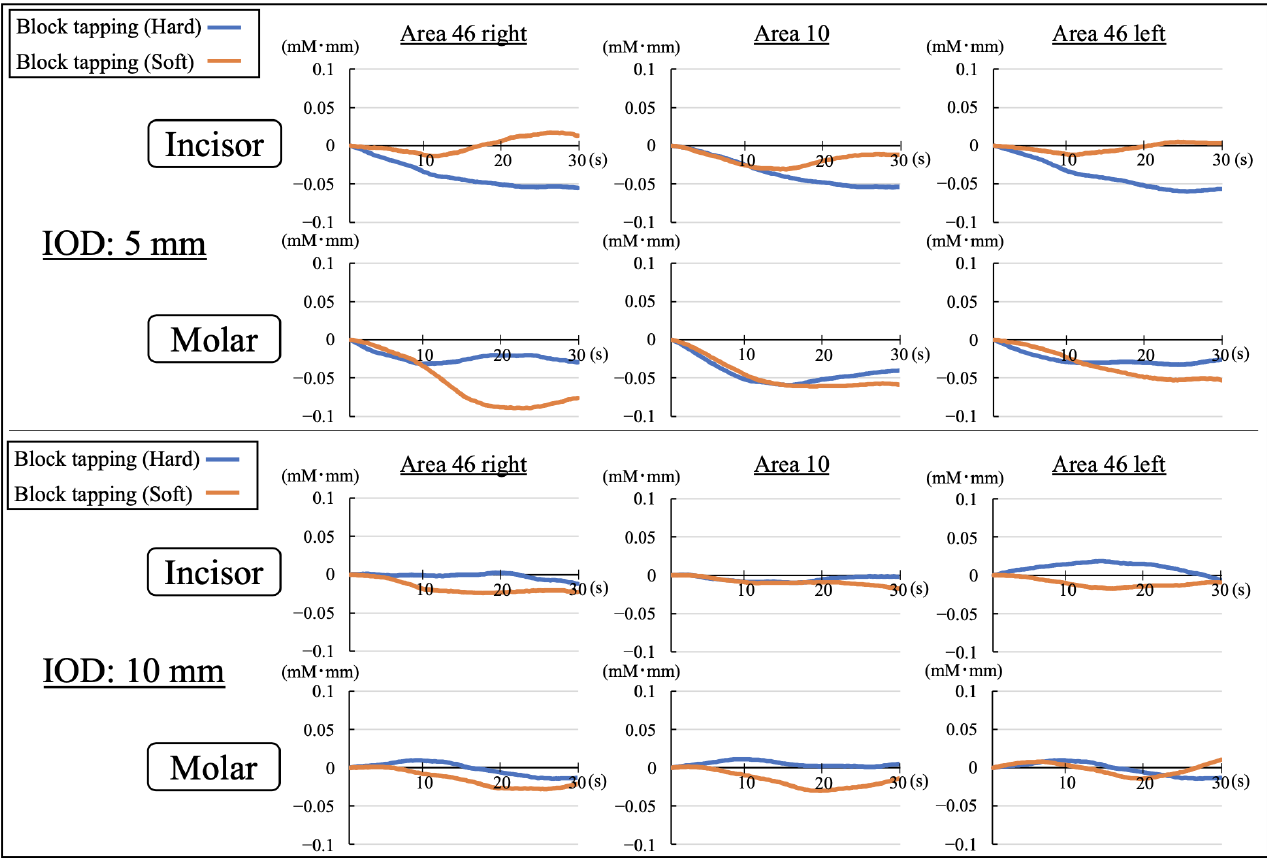
Figure 2. Signal averaging patterns of the cerebral blood flow in the prefrontal cortex with IODs of 5 and 10 mm (IOD: interocclusal distance).